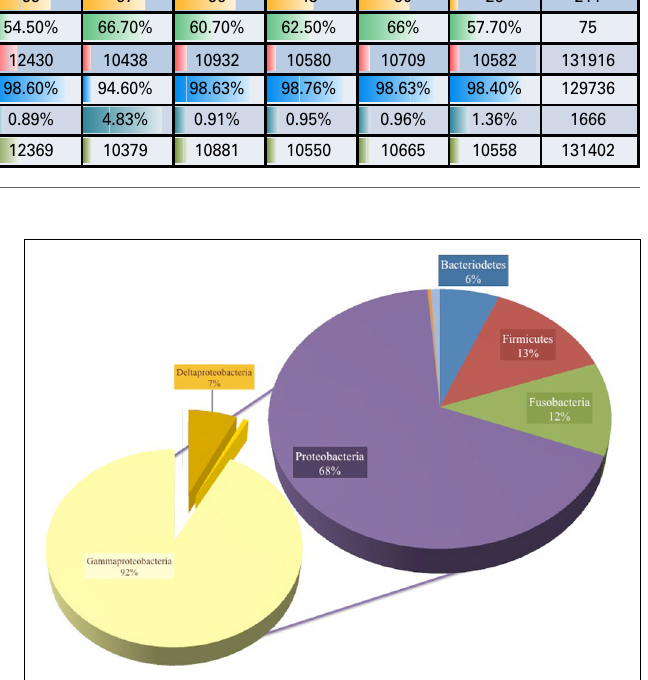
FIGURE 2 | Pie chart representation of the total cultured phyla in all samples, showing 68% Proteobacteria, 13% Firmicutes, 12% Fusobacteria, 6% Bacteroidetes and unknown bacteria and organism phyla (percent abundance not shown). The composition was 92% γ -proteobacteria, 7% δ -proteobacteria and the remaining Proteobacteria were assigned as ε -proteobacteria.